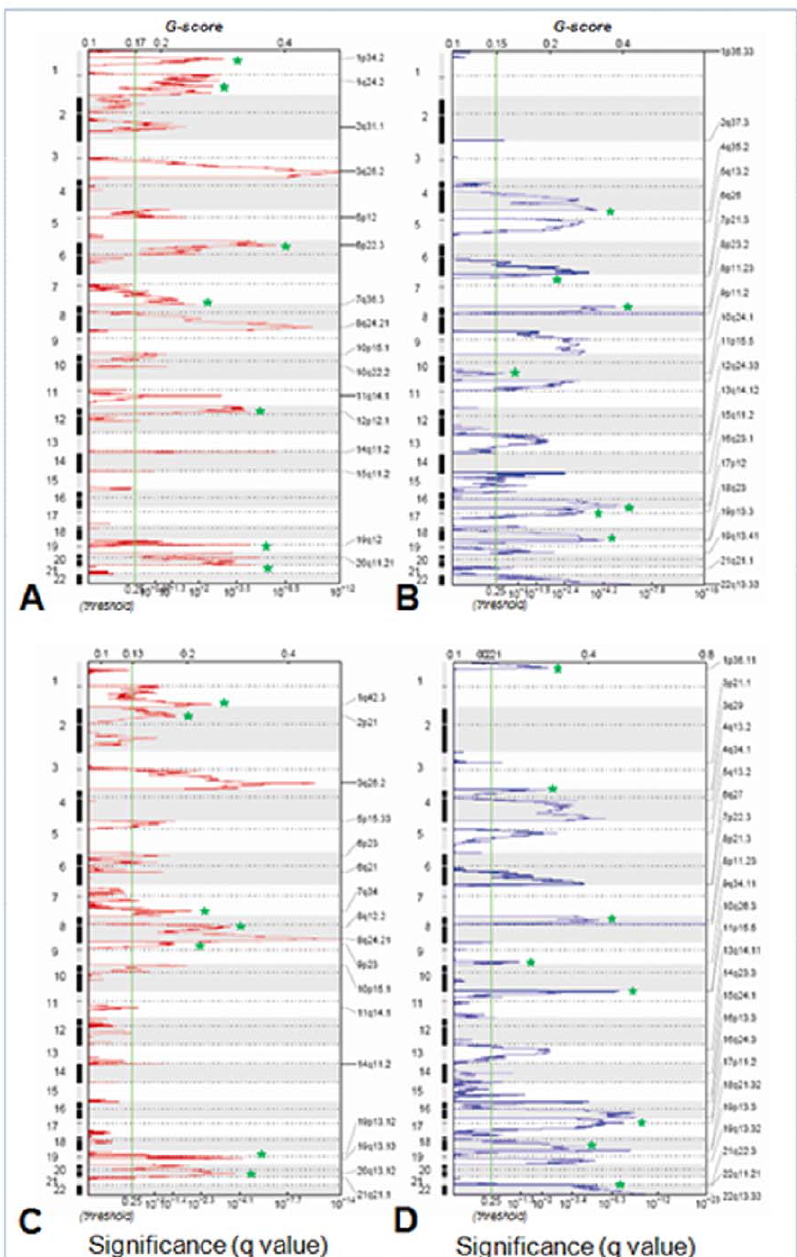
Figure 3. GISTIC analysis of patient subgroups. A–B ) Cluster 1; C–D ) Cluster 2 amplification and deletion peaks defined by GISTIC in two patient subgroups show clear difference in the location of peaks. Green stars indicate major differences between the two subgroups. Probes from these regions were used to build the model for training.